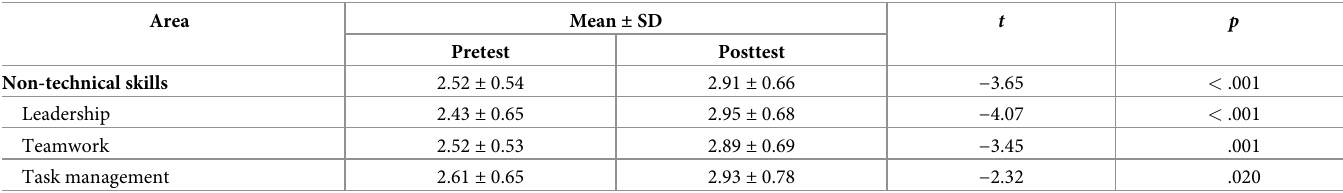
Table 2. Effects of neonatal resuscitation program simulation on non-technical skills. (n = 40).